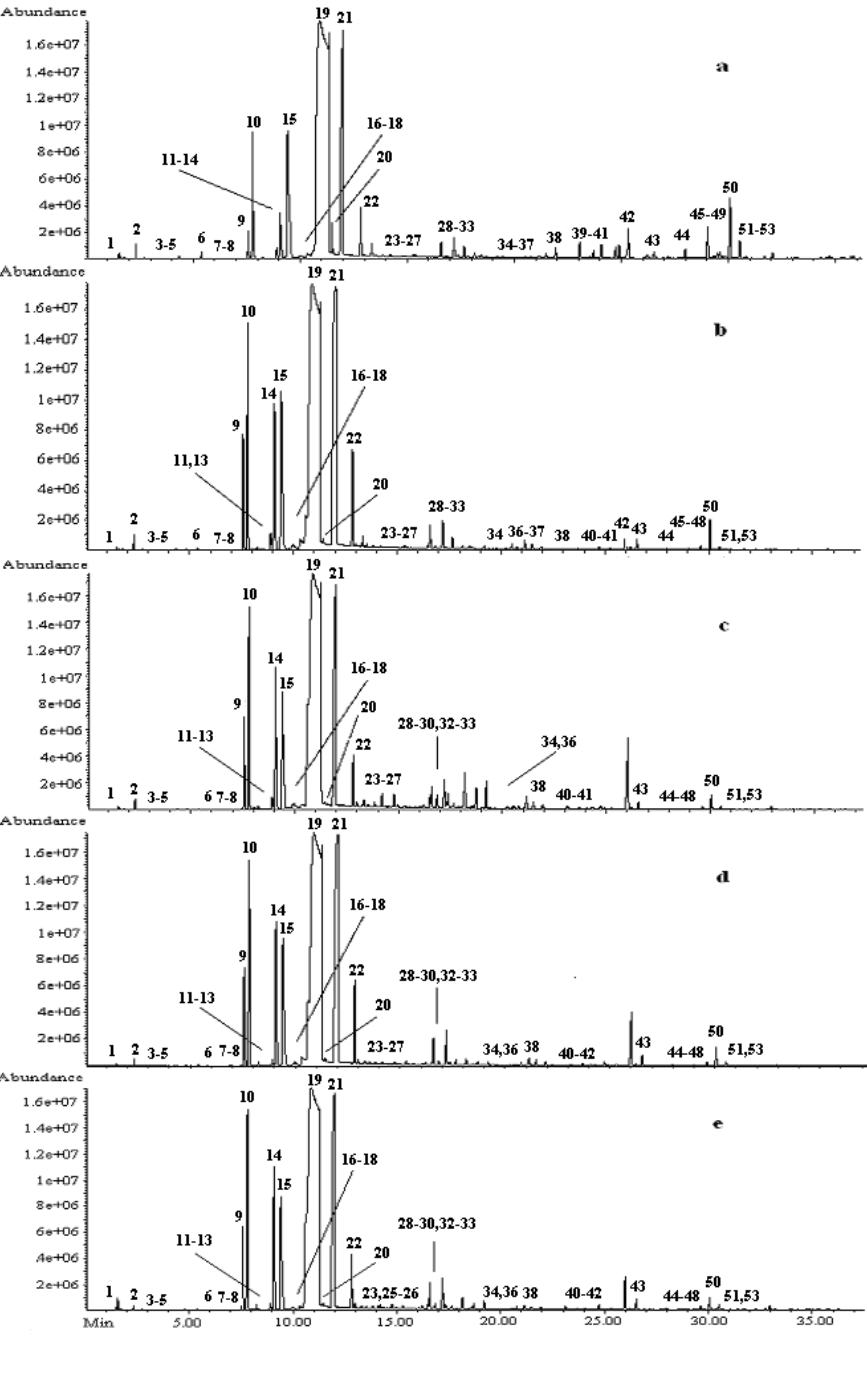
Figure 1. GC chromatogram of PCR essential oil at different storage time a : Chachi 2008, b : Chachi 2004, c : Chachi 2001, d : Chachi 1998, e : Chachi 1994. Component numbers in the chromatogram come from Table